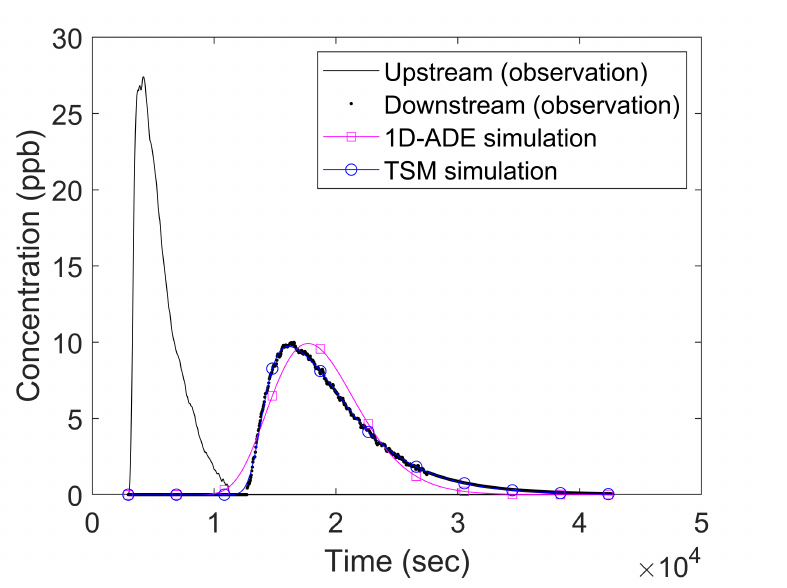
Figure 1. Schematics of the surface, hyporheic transient storage zones in an alluvial valley (modified after [11–15]).